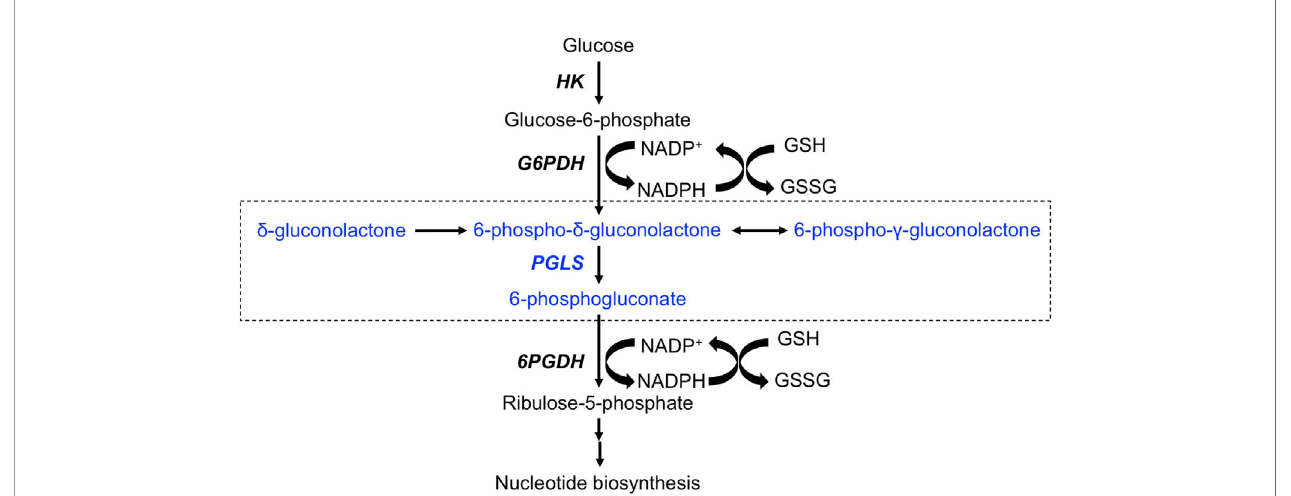
FIGURE 1 | Schematic illustration of the PPP. The portion of the pathway illustrating entry of d -[1- 13 C]gluconolactone and metabolism to [1- 13 C]6PG are highlighted in blue and enclosed in a box. HK, Hexokinase; G6PDH, glucose-6-phospate dehydrogenase; PGLS, 6-phosphogluconolactonase; 6PGDH, 6-phosphogluconate